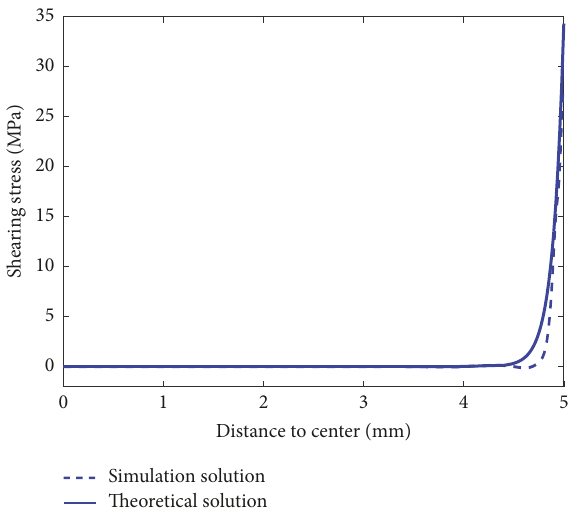
(a) Radial normal stress of Si